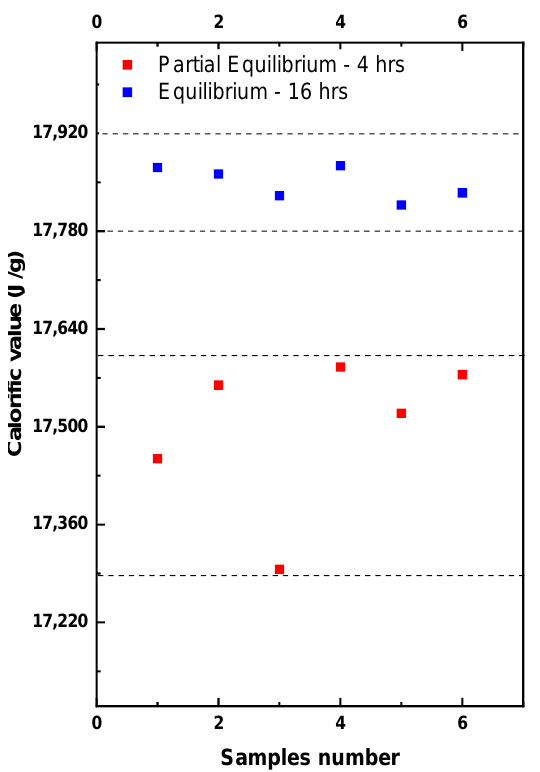
Figure 6. EMC effect on the wet basis calorific value and the sample repeatability. Partial equilibrium refers to the tests performed in the bomb calorimeter after grinding that lasted around 4–6 h. These tests showed high fluctuation in the determined calorific values (red symbols). After 16 h the samples were retested again and shown in the figure as equilibrium (blue symbols). If the equilibrium was reached, the repeatability significantly improved and the deviation between the samples became less than 60 J compared to 280 J in partial equilibrium. This was due to the stability of the sample mass because of the more stable moisture content. The EMC effects upon the calorific value repeatability depended significantly on the laboratory conditions. A repeatability improvement by up to 50–80% was achieved, which consequently contributed to minimizing the reproducibility